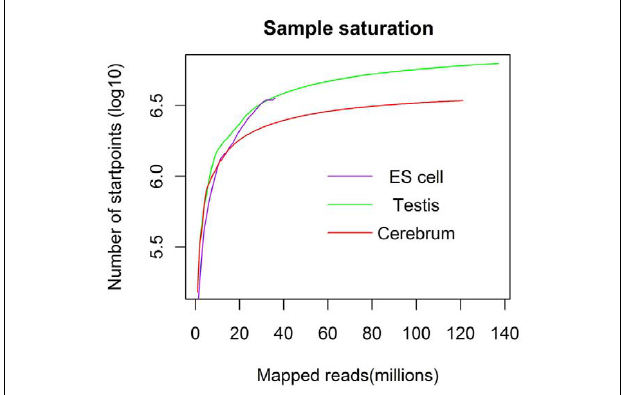
FIGURE 1 |The saturation curve for the number of start-points of mapped reads. x -Axis shows the number of the mapped reads and y -axis displays the start-points number (million) of mapped